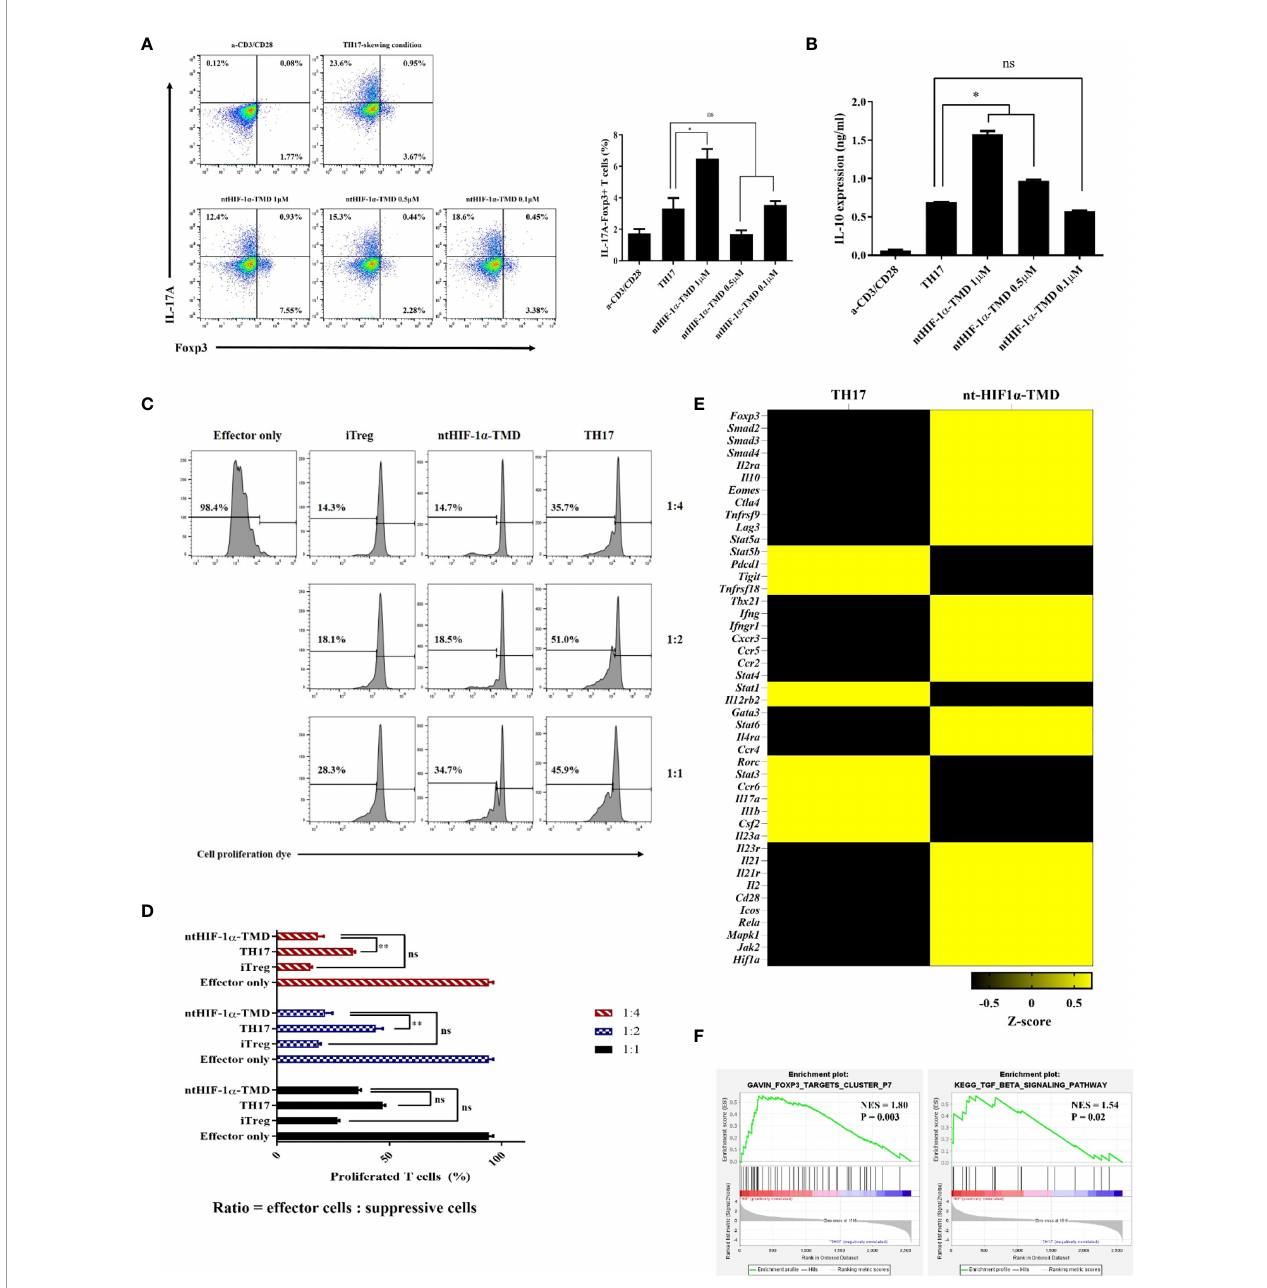
FIGURE 3 | The functional conversion of TH17 cells into T cells with the immune-suppressive phenotype. (A) In the TH17-skewing condition, the change of IL-17A or Foxp3 expression in TH17 cells treated with ntHIF-1 a -TMD were analyzed by fl ow cytometry. (B) The amount of IL-10 in the supernatant from T cells in (A) was measured by ELISA. (C, D) The immune-suppressive function of TH17 cells treated with ntHIF-1 a -TMD was evaluated by suppression assay. (E) Expression heatmap of helper T cell-related genes. Z-score was calculated from log2(TPM+1). (F) GSEA-based enrichment plots of the Foxp3 targets cluster or TGF- b signaling pathway. Experiments in (A – D) were performed three times. Data are represented as mean ± SEM ( n ≥ 3), and Student ’ s t - test was performed for statistical analysis. ns, not signi fi cant, *P < 0.05, **P <